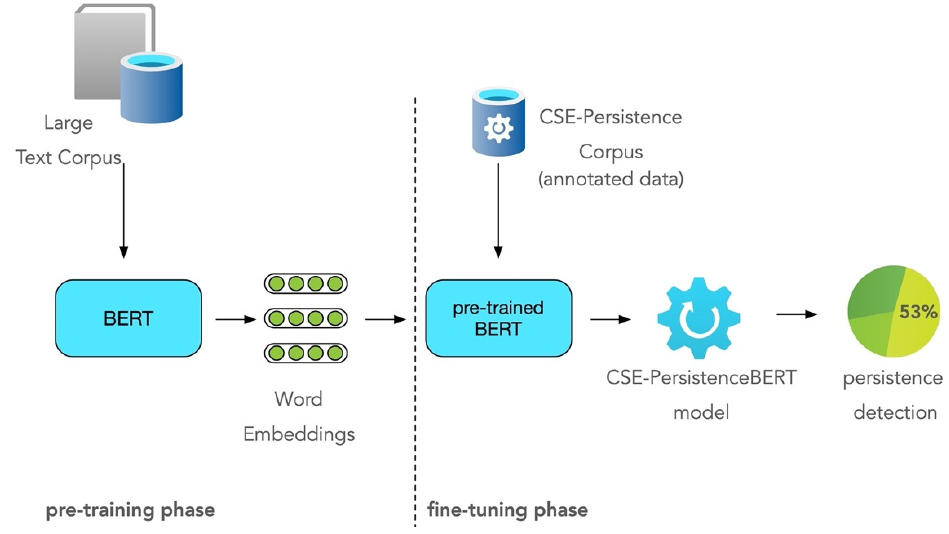
Figure 2. The proposed Transfer Learning approach.